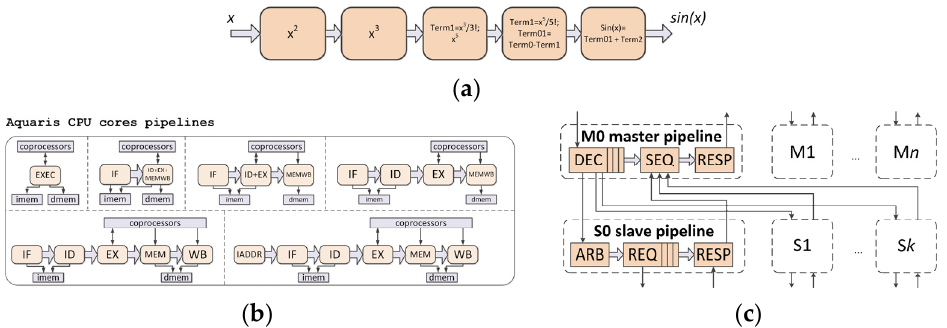
Figure 4. Demo pipelined designs based on Pipex KIP core: sine wave generator based on Taylor series ( a ), RISC-V CPU core ( b ), and master and slave pipelines in full cross-bar ( c